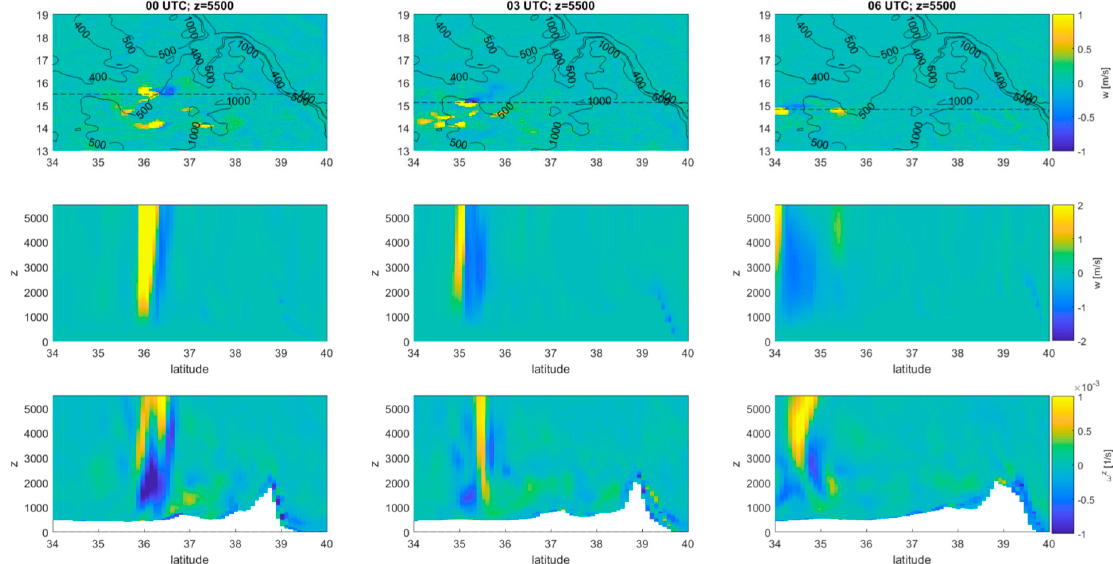
Figure 15. Plan views of vertical velocity, w , at z = 5500 m (top row); vertical sections of w (middle row), with the section positions indicated by the dashed lines in the upper panels; vertical sections of the vertical component of relative vorticity ζ (bottom row) over the same sections. The three columns of panels are taken at the times